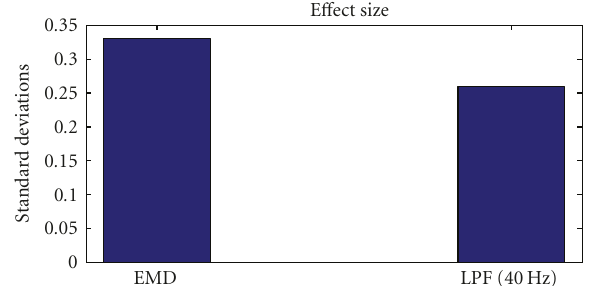
Figure 8: Bar graph comparison of amplitude deviation for EMD- based and raw single trials. Lower amplitude deviation indicates better performance.